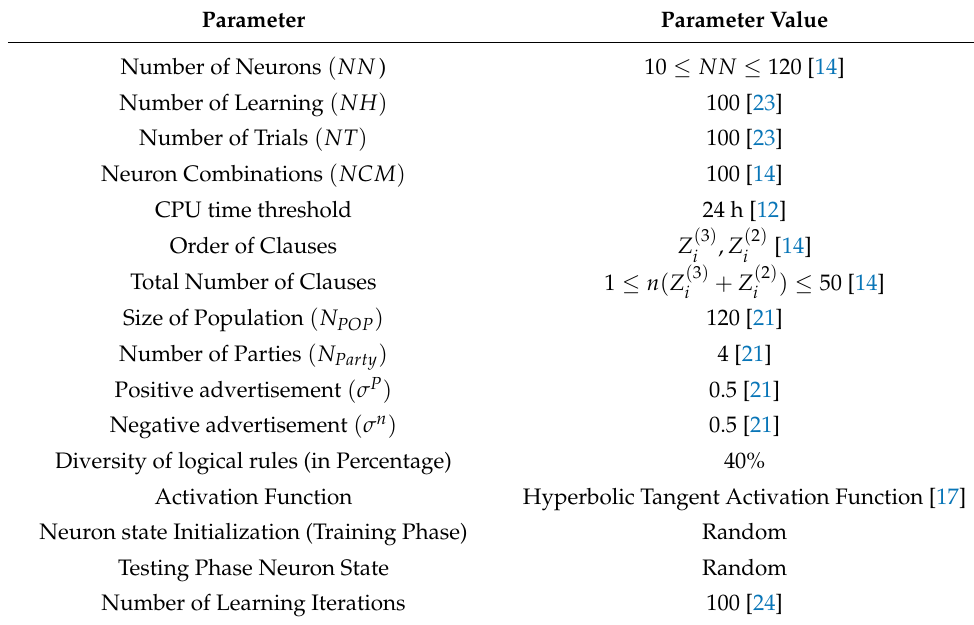
Table 2. Parameter list for the DHNNRAN k SAT-HEA model.